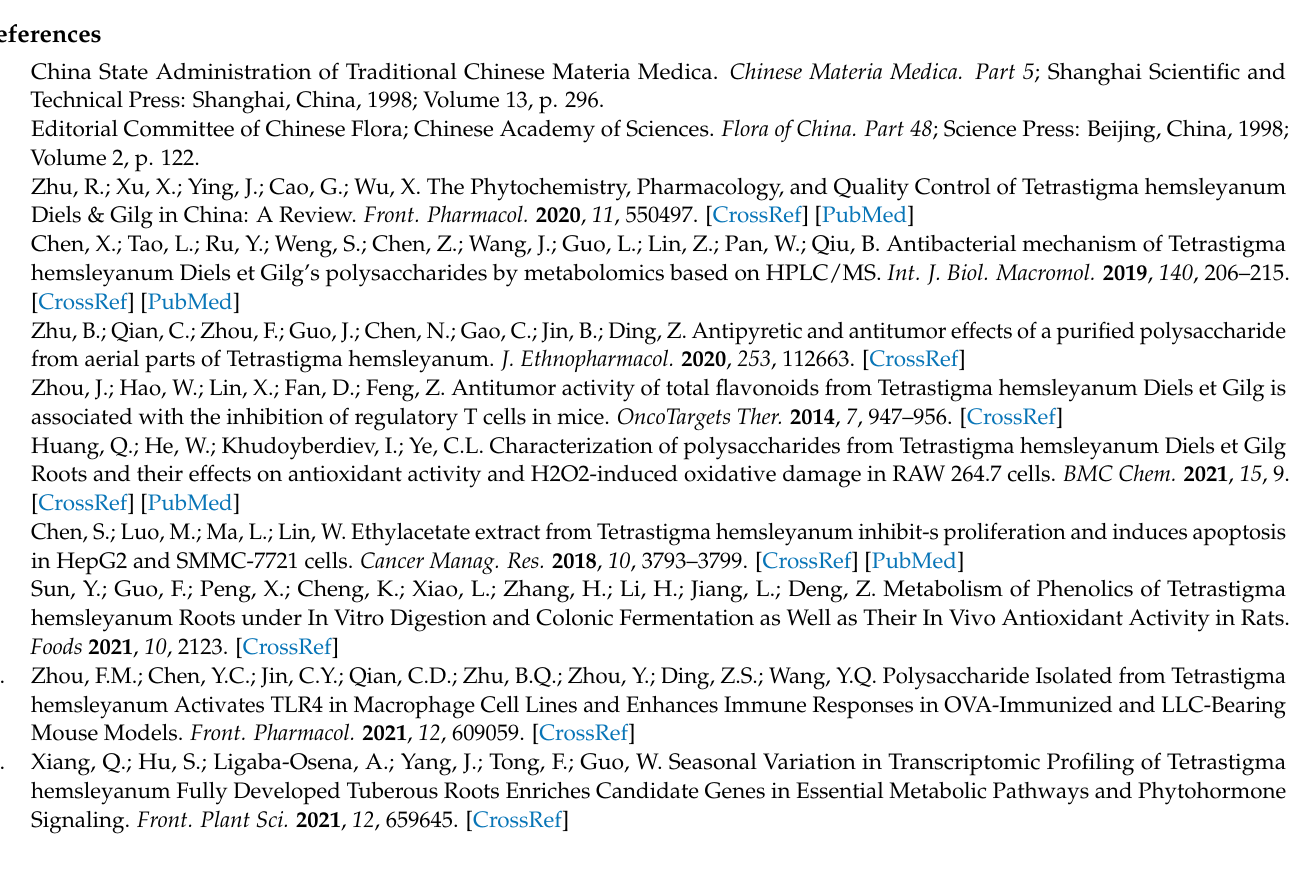
Figure S3: The MS spectra of 28 constituents in positive ion